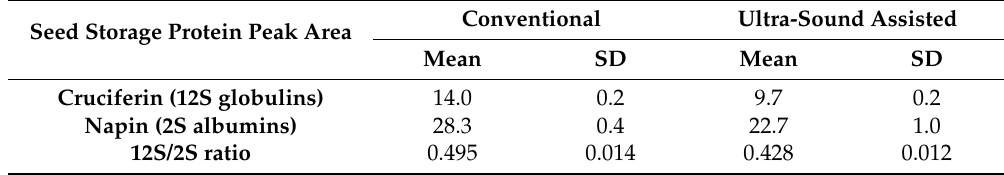
Table 2. Seed storage protein composition in conventional or ultra-sound assisted extract. Seed Storage Protein Peak Area